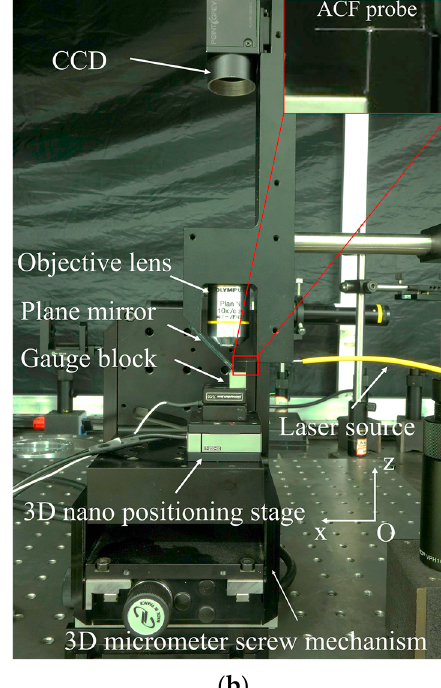
Figure 6. The relationship between the Young’s modulus of the cured glue.